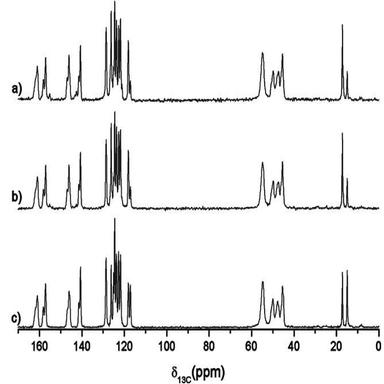
13C ss-NMR spectra of OLZ samples a) A, b) B and c) C.